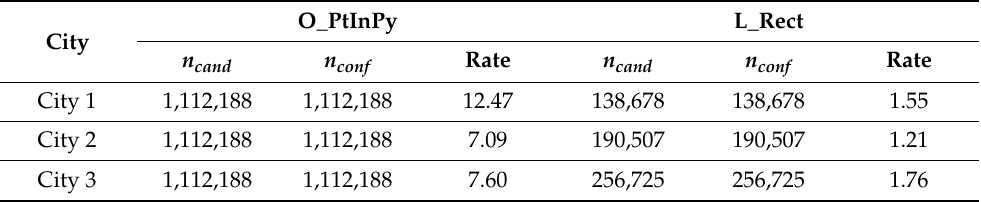
Table 3. Comparison of candidate points, confirmation points, and inner points. The rate is n cand divided by n inner .